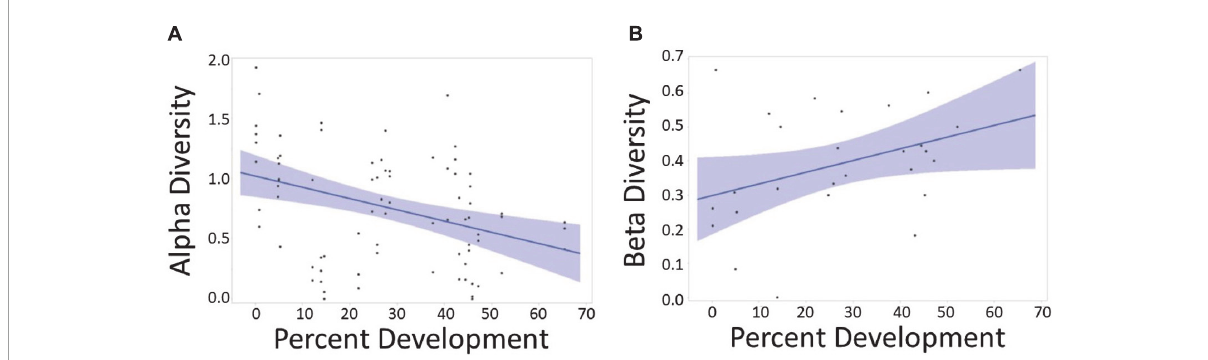
FIGURE2 Percent development around a 2 km radius of field sites against alpha and beta diversity. (A) Plot showing alpha diversity where each data point represents Shannon’s diversity at one of the three quadrats at each site. As surrounding percent development increased, alpha diversity decreased [ F ( 1 , 12 ) = 7.24, p = 0.020]. (B) Plot showing beta diversity where data points reflect beta diversity across each site. As percent development increased, beta diversity increased [ F ( 1 , 12 ) = 4.50, p = 0.055].